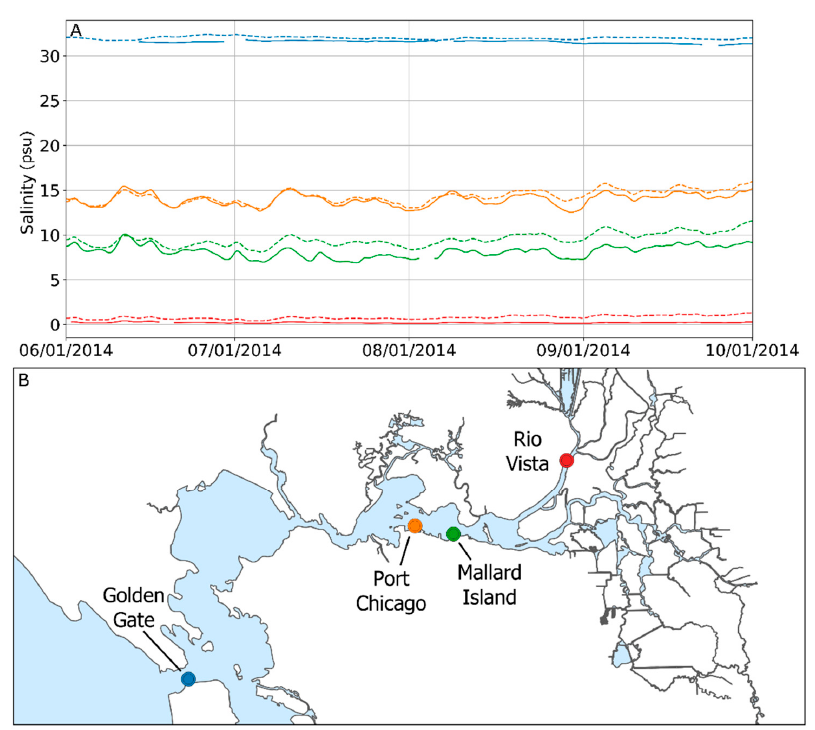
Figure 5. Observed (solid lines) and predicted (dashed lines) tidally-averaged salinity at four stations along the axis of the northern San Francisco Estuary. Line colors of panel ( A ) correspond to marker colors of panel ( B ).